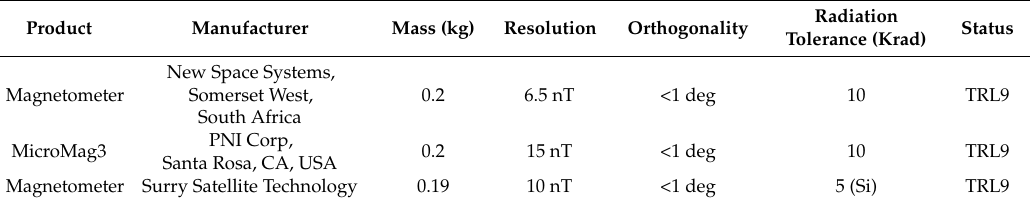
Table 18. Magnetometer Performance Data (CubeSatShop, 2017) [51,52].